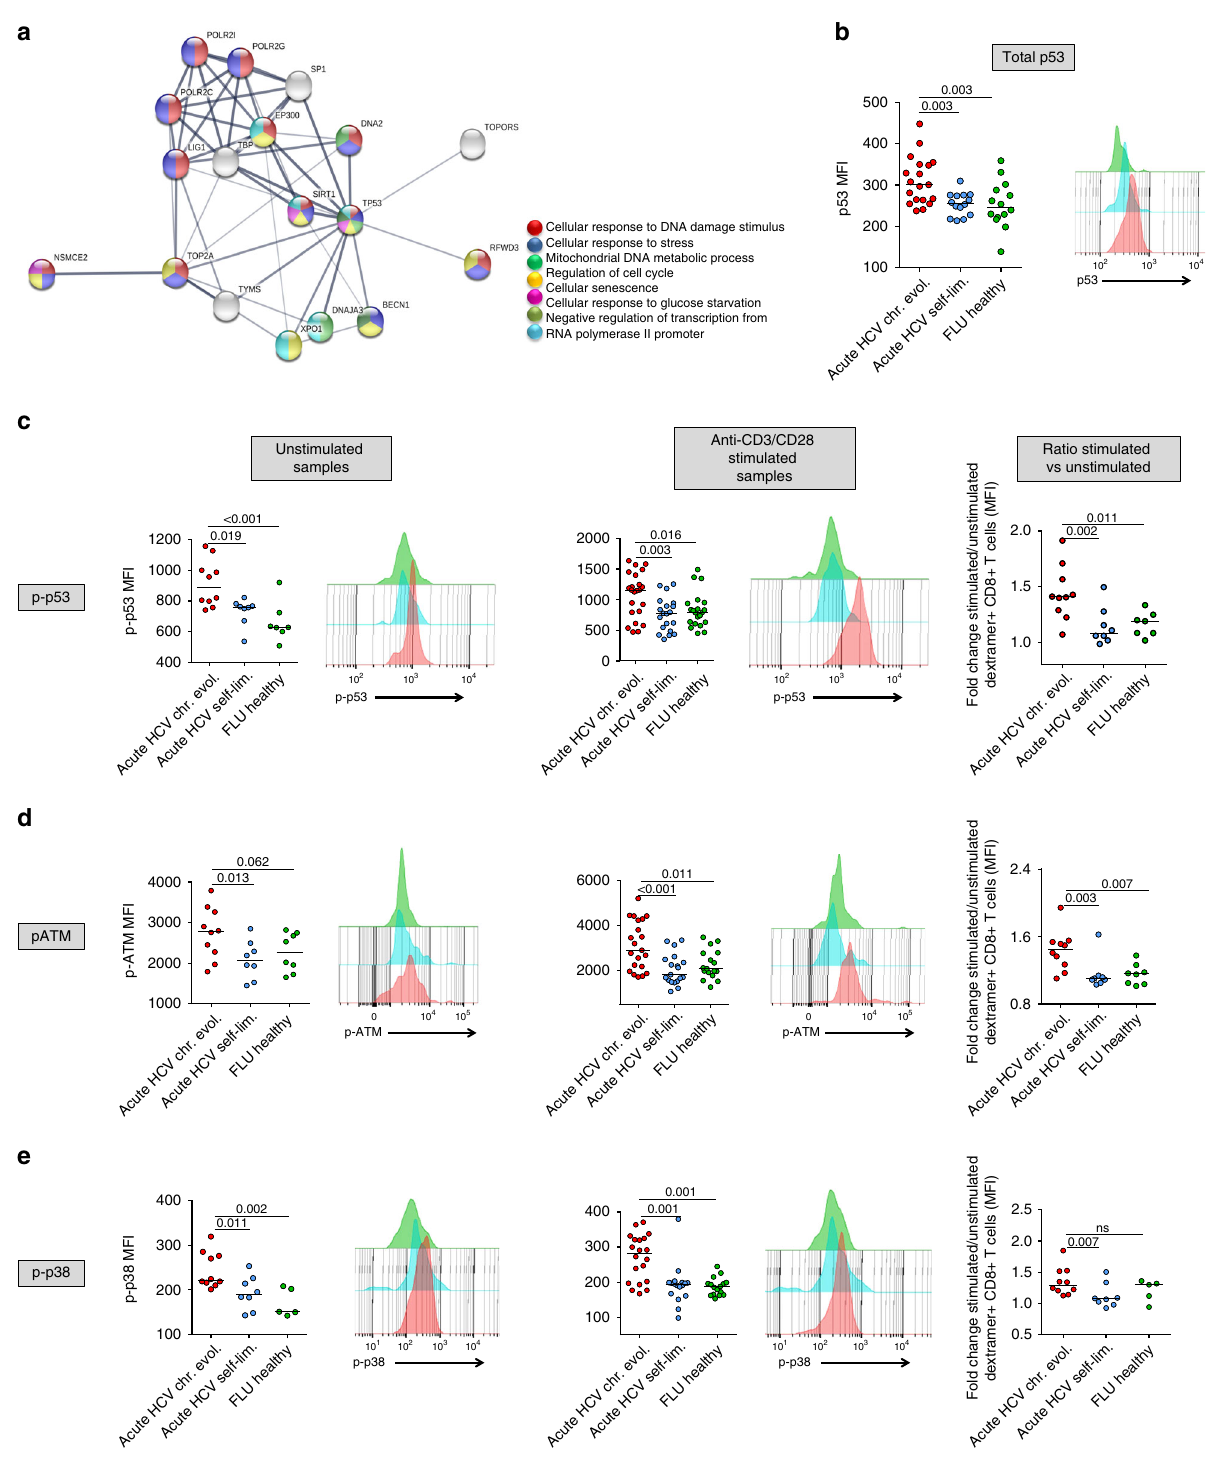
Furthermore, a signi fi cant reduction of mitochondrial polarization (Fig. 6c, left panel) and a marked accumulation of proteasome-undegraded aggregated proteins (Fig. 6c, right panel) were detected ex vivo in HCV-speci fi c CD8 + T cells from T2/late chronic compared to T2/late resolved patients and healthy controls. Further investigation of cellular metabo- lism at the T1 and T2 time-points, revealed sustained glucose uptake and GLUT1 expression levels in T2/late chronic patients